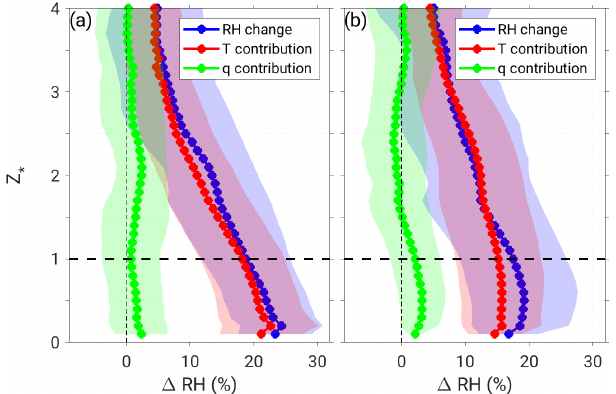
Figure 4. Specific humidity ( q ) and temperature ( T ) mean contribu- tions to the mean total change in relative humidity (RH) at (a) Savè and (b) Kumasi averaged over all available IOPs. The shading in- dicates the standard deviation. The horizontal dashed line ( Z ∗ = 1) indicates the CBH when the stratus clouds